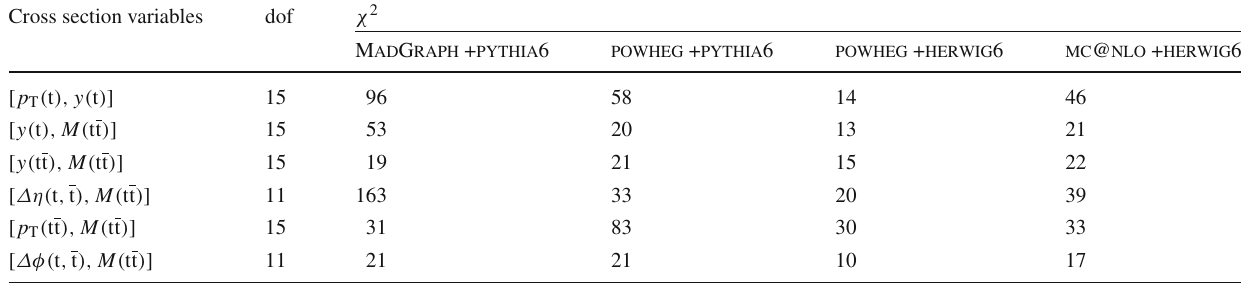
Table 1 The χ 2 values and dof of the measured normalized double-differential tt cross sections with respect to the various MC predictions Cross section variables dof χ 2 MadGraph + pythia 6 powheg + pythia 6